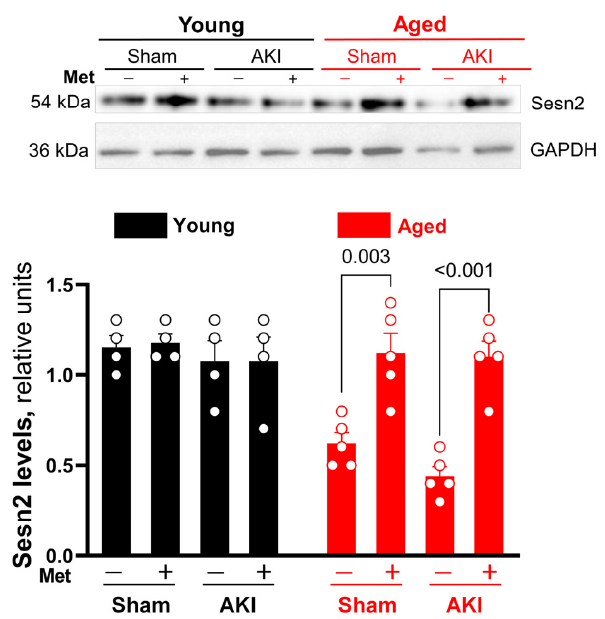
Figure 4. Western blot representative images and statistical analysis. Sesn2 expression in young vs. aged hearts in sham and AKI conditions. Analysis represented as mean ± SEM; n = 4–5 per group.